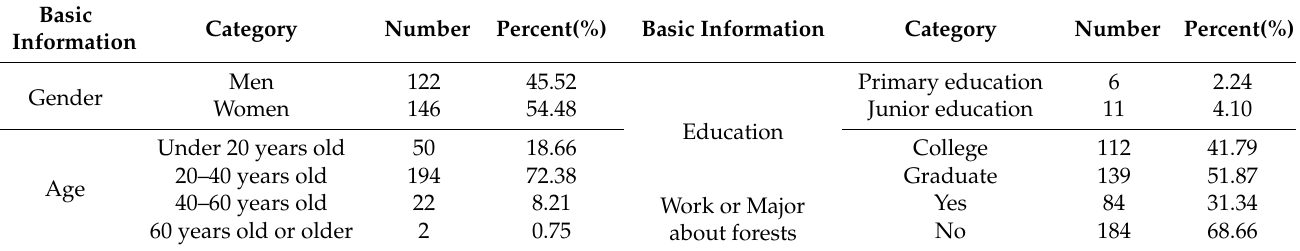
Table 1. Basic demographics of questionnaire